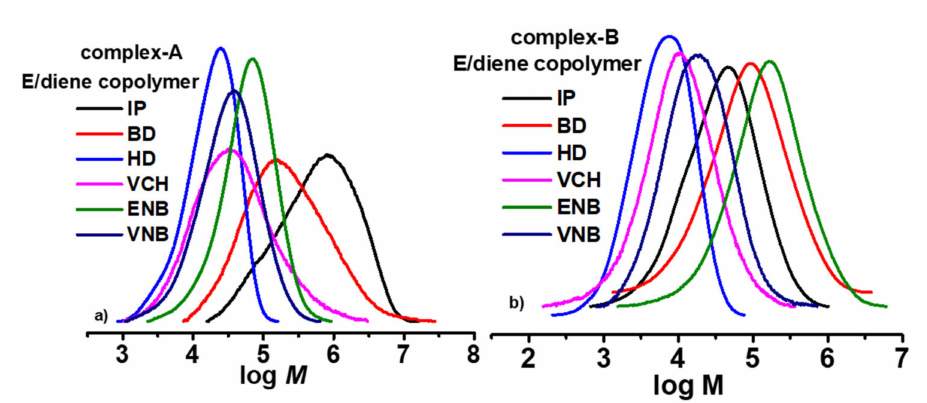
Figure 5. Molecular weight distribution (MWD) for ethylene/diene (conjugated and nonconjugated) terpolymers produced with ( a ) complex A and ( b ) complex